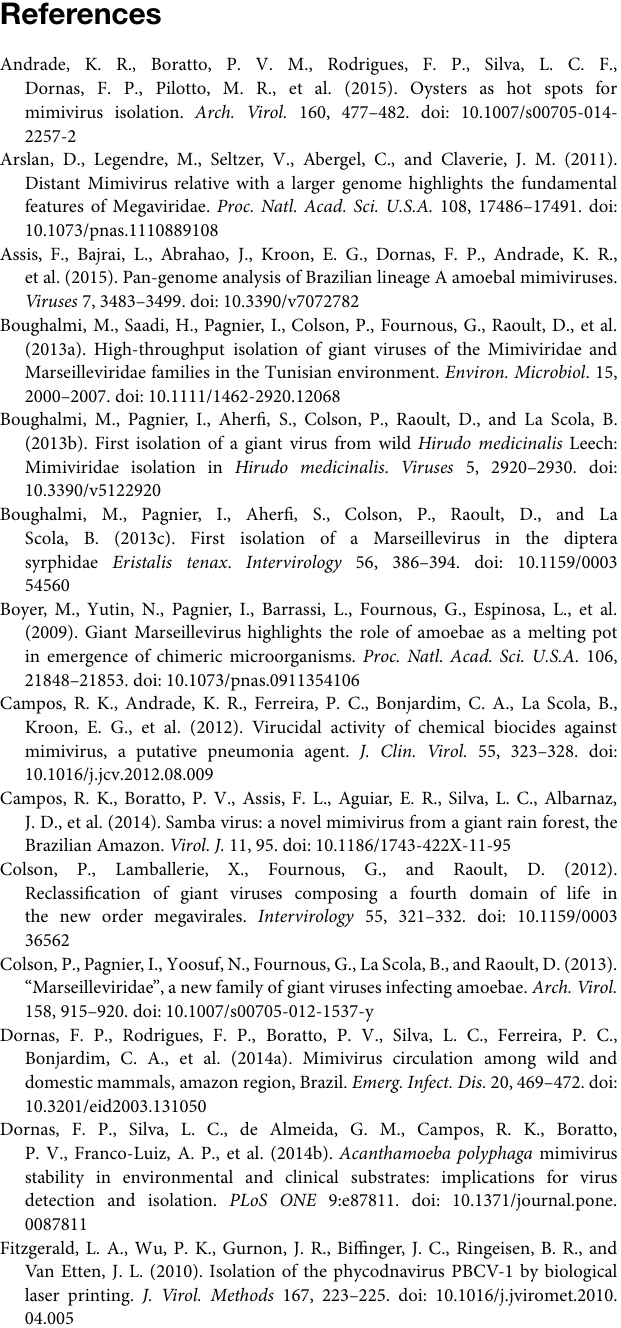
FIGURE S1 | Images obtained from the hemacolor staining of some viruses isolated. Cytospin, fixation and stain were done after 18 h post infection. The asterisks in the image show the viral factory and the arrows in Figure 2 . (G) show the Pandora’s virus particle. Original magnification × 1000. (A) Negative control Acanthamoeba castellanii ; (B) AC BZ 01 Marseillevirus; (C) AC BZ 16 Mimivirus; (D) AC BZ 24 Mimivirus; (E) AP BZ 04 Mimivirus; (F) AP BZ 87 Mimivirus; (G) AC BZ 81 Pandoravirus. FIGURE S2 | Images obtained from the labeling fluorescence DAPI of some viruses isolated and inoculated in same cellular system isolated.